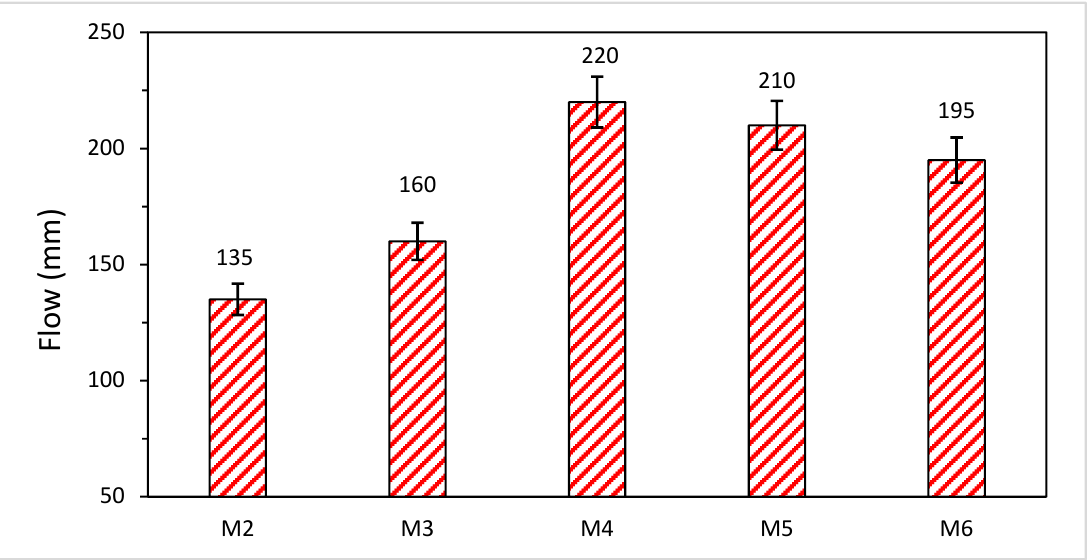
Figure 4. Flowability of the AANL M at varying Na 2 SiO 3(aq) /10 M NaOH (aq) (SS/NH) ratio. (M2 = AANL M 0.5, M3 =